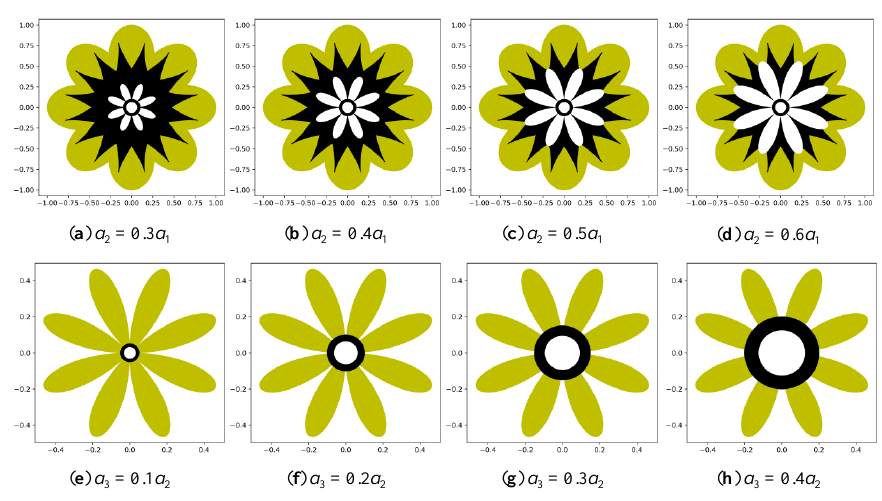
Figure 7. Di ff erent flower patterns generated by setting parameters a 2 and a 3. Figure 7. Different flower patterns generated by setting parameters a 2 and a 3.